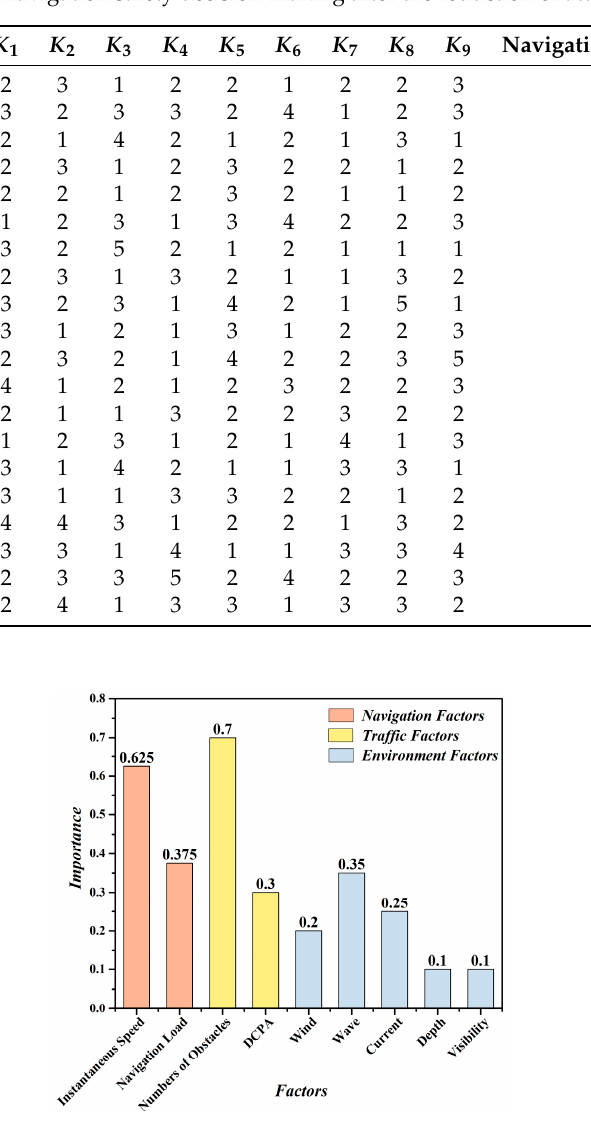
Table 3. Table of navigation safety decision-making after the reduction of attribute values.